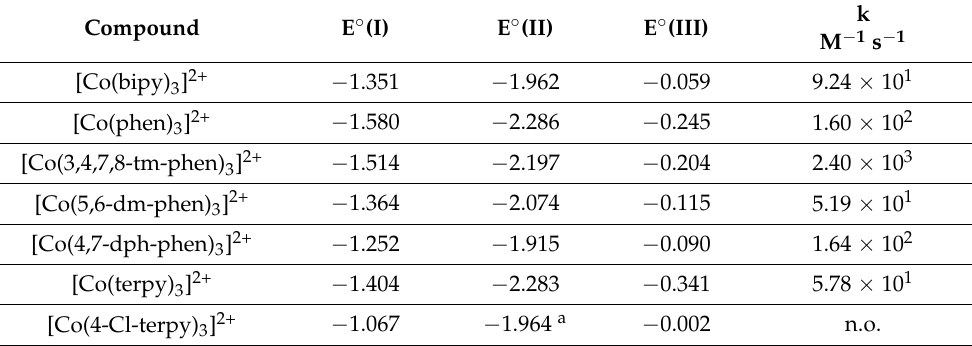
Table 1. Redox potential values E ◦ of the processes I, II, and III of the compounds [Co II (L) 3 ] 2+ and [Co II (L ´ ) 2 ] 2+ and their catalytic constant values for mediated CO 2